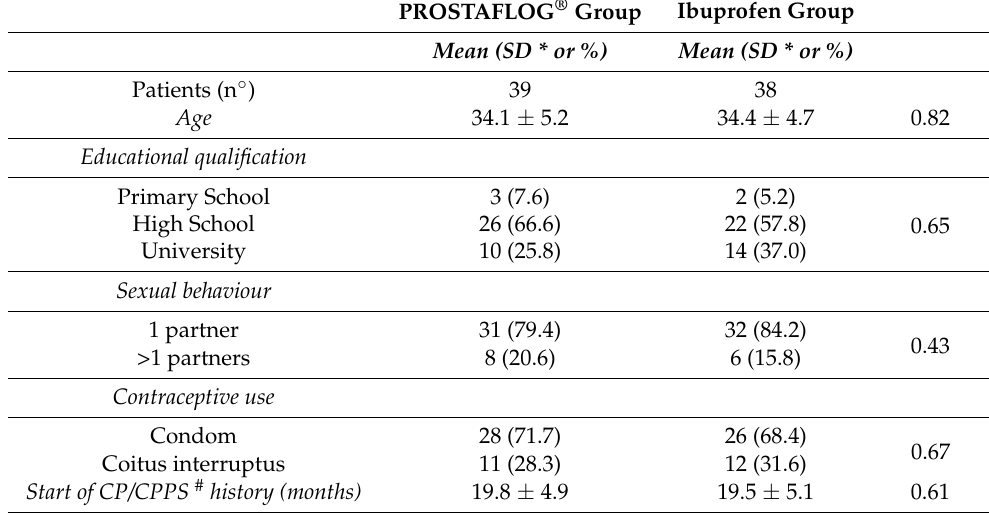
Table 1. The demographic and clinical patient’s data at the enrolment time (per protocol